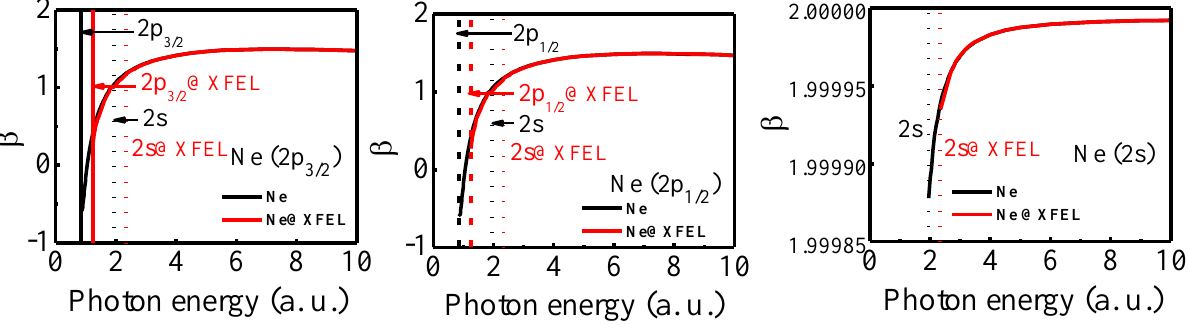
Figure 4. Angular distribution asymmetry parameter ( β ) of 2p 3/2 ( Left ), 2p 1/2 ( Middle ), and 2s ( Right ) subshells of Ne (black) and Ne@XFEL (red). Solid, dashed, and dotted vertical lines represent the threshold for 2p 3/2 , 2p 1/2 , and 2s thresholds of free (black) and confined atom (red), respectively.